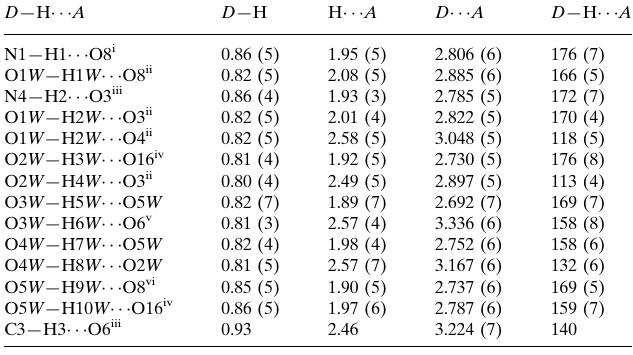
Data collection Bruker APEXII area-detector diffractometer Absorption correction: multi-scan ( SADABS ; Sheldrick, 1996) T min = 0.215, T max = 0.296 Refinement 397 parameters 12 restraints